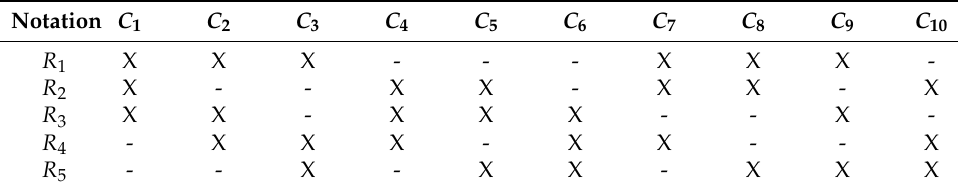
Table 4. Representation of all possible combinations of applied